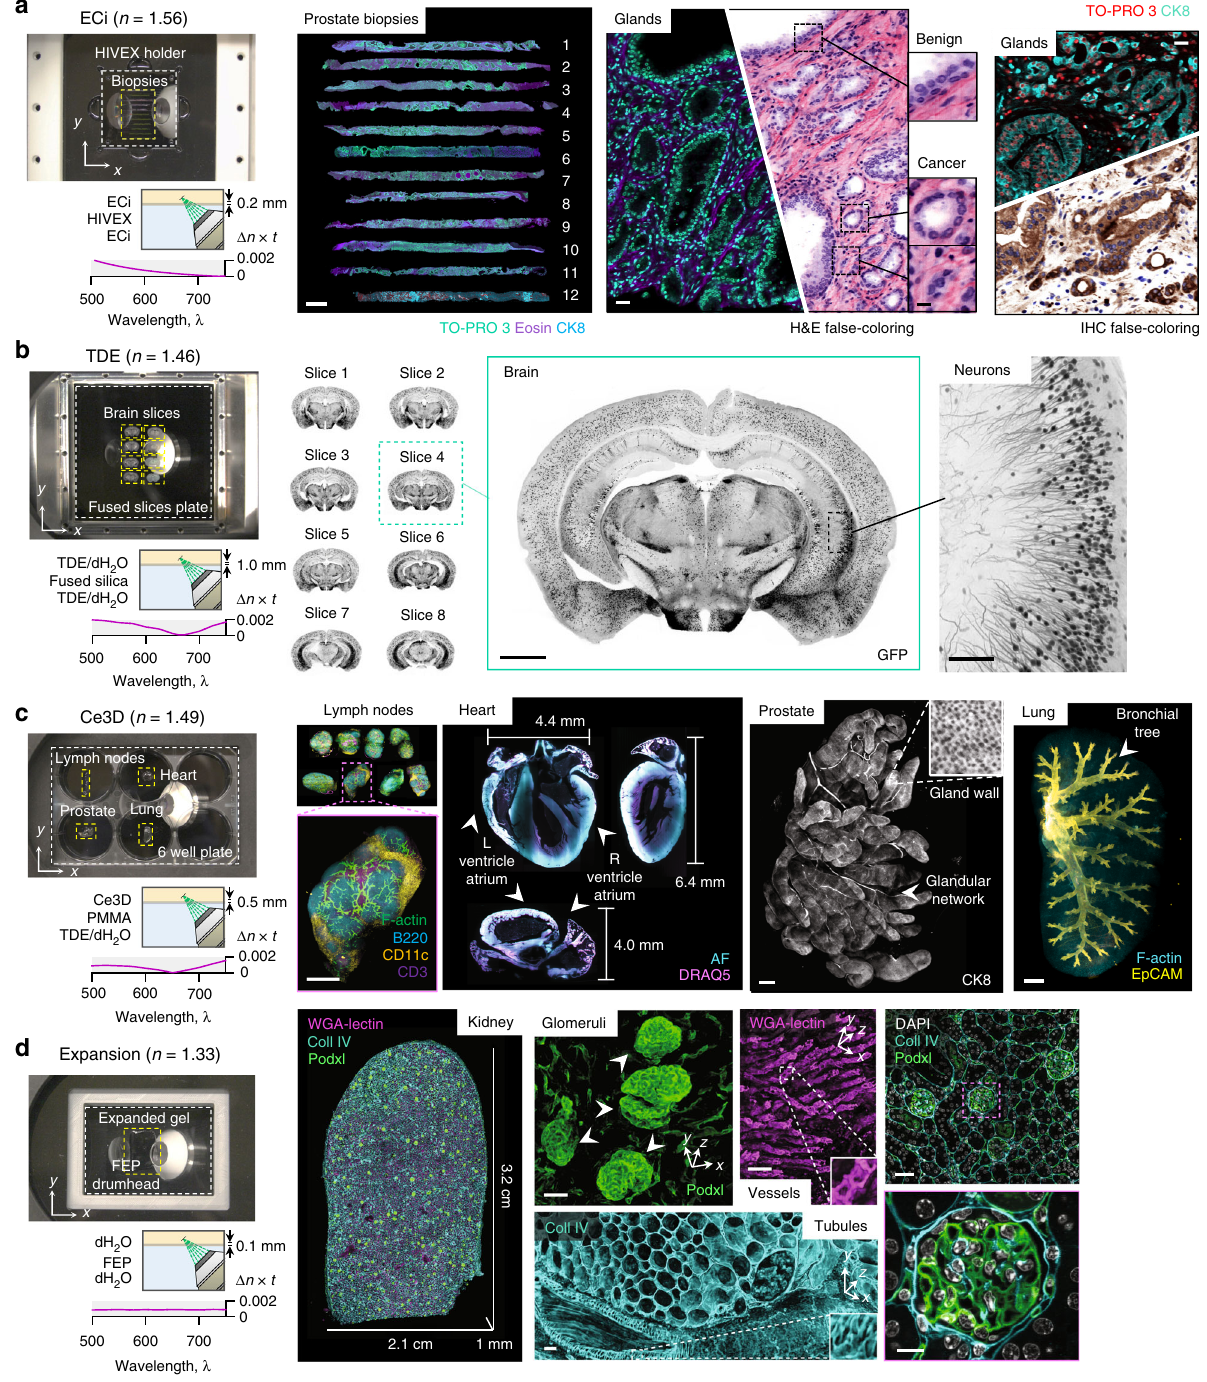
Fig. 3 Multi-immersion and multi-specimen imaging. a OTLS imaging of 12 ECi-cleared human prostate biopsies (scale bar: 1 mm) placed within a multi- biopsy holder. Zoomed-in views illustrate the complex 3D structure of benign and malignant glands (scale bars: 25 μ m and 10 μ m). Images can be false- colored to mimic the appearance of conventional chromogen-based (absorption-based) H&E and IHC histopathology. b High-throughput imaging of eight TDE-cleared mouse brain slices placed on a 10 × 10 -cm glass plate (scale bar: 1 mm). A higher-magni fi cation region of interest demonstrates the ability to visualize individual neurons (scale bar: 100 μ m). c Whole-organ imaging of Ce3D-cleared mouse lymph nodes, heart, prostate, and lung placed within an multi-well plate (scale bars: 1 mm). d Large-scale imaging of an expanded thick-kidney slice placed on a te fl on drumhead. High-resolution regions of interest show individual glomeruli (scale bar: 40 μ m), vessels (scale bar: 80 μ m), and tubules (scale bar: 50 μ m). A multi-channel zoom-in with DAPI counterstaining demonstrates the increased resolution due to expansion (scale bars: 100 μ m and 20 μ m). The scale bars for the entire expanded kidney indicates the physical size of the expanded specimen, whereas the scale bars for the insets indicate the dimensions of the